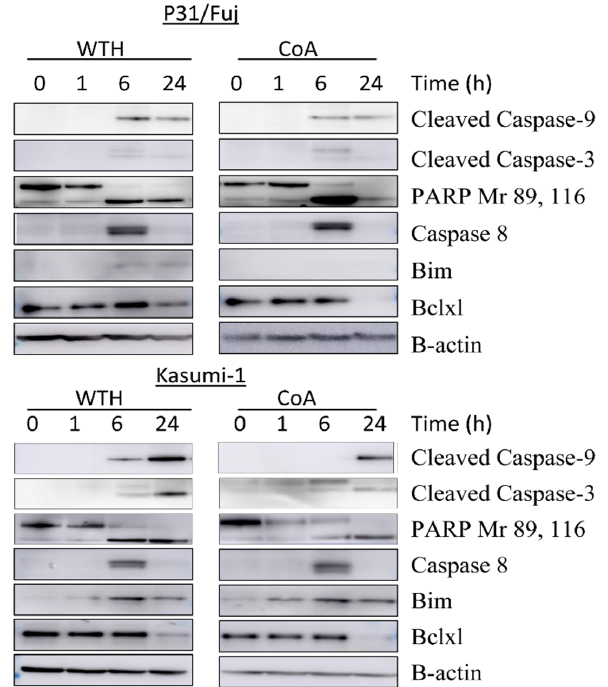
Figure 7. The withanolides induce apoptotic markers. Western blot images of the named markers are shown. See methods for details of antibodies used.